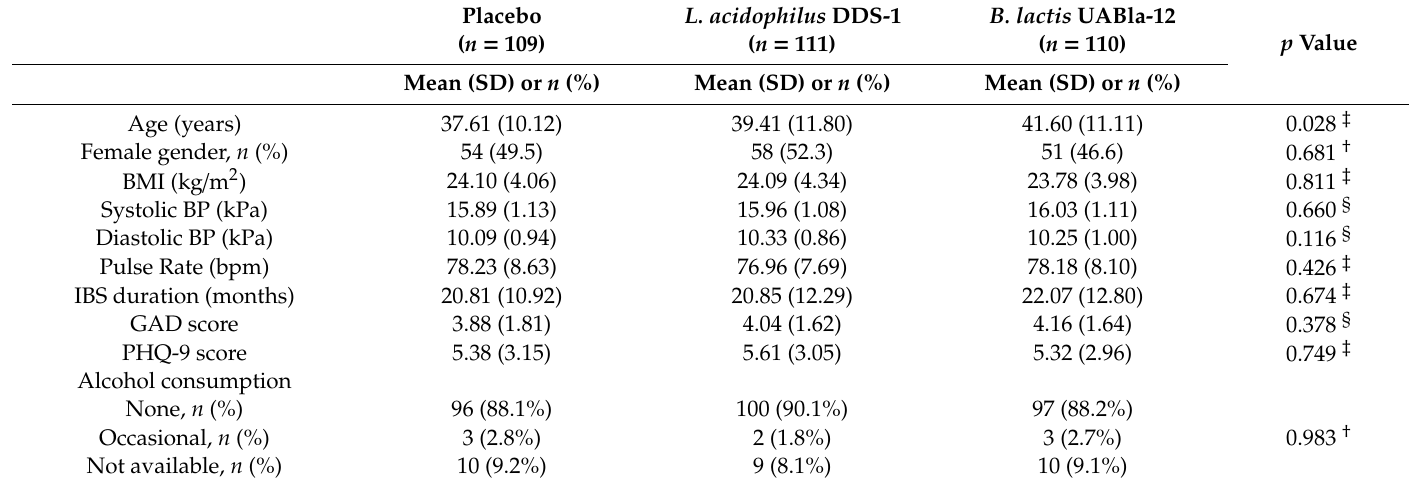
Table 1. Baseline demographics and clinical characteristics of the ITT population.